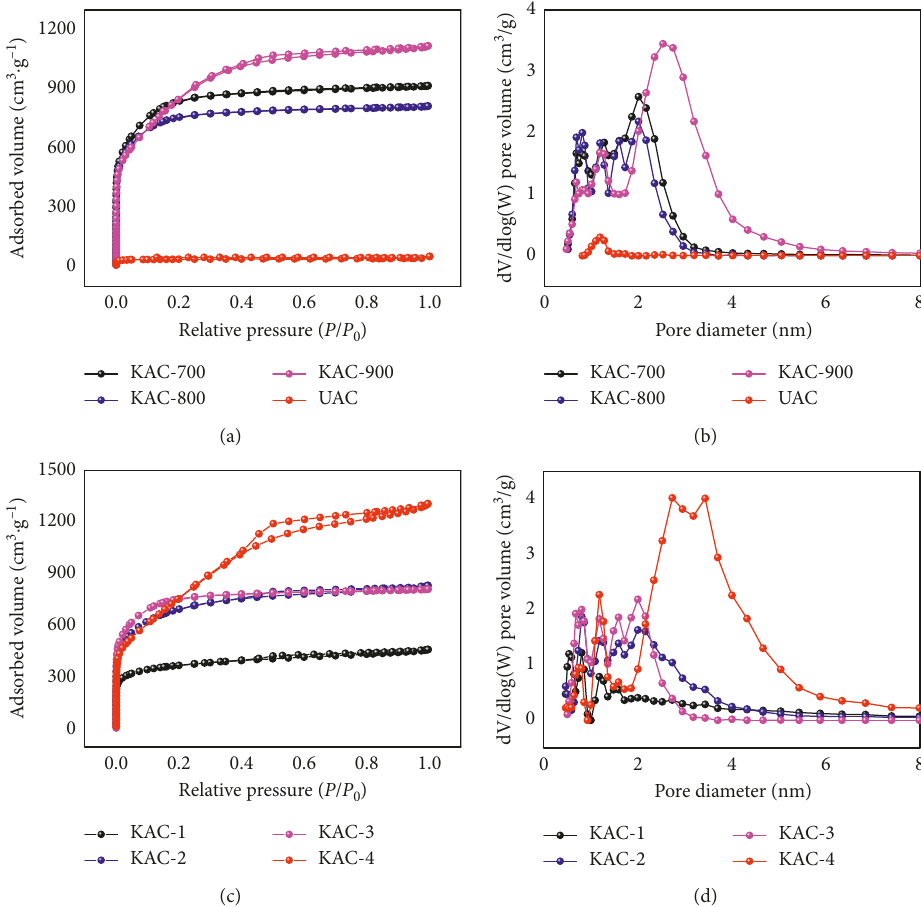
Figure 4: Nitrogen adsorption/desorption isotherms (a, c) and DFTpore size distribution curve (b, d) of KAC-based samples in comparison with UAC. Table 1: Texture properties of the KAC samples achieved under different conditions and UAC. a